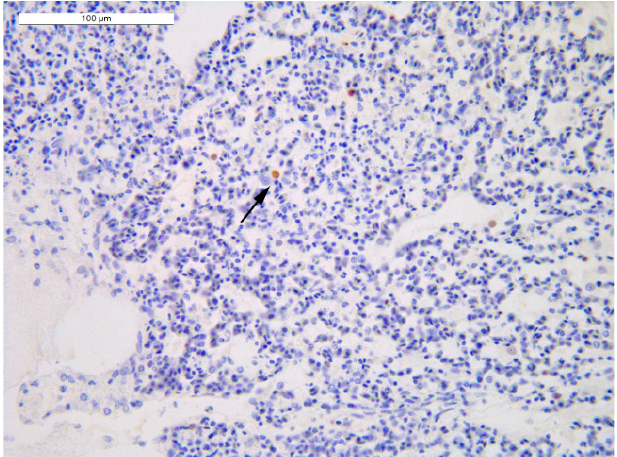
Figure 7. Lung of the broiler 4 of house 3 (IHC): barely/occasional presence of immunolabelled pneumocytes (black arrow) detected as nuclear brown staining ( − /+ score).